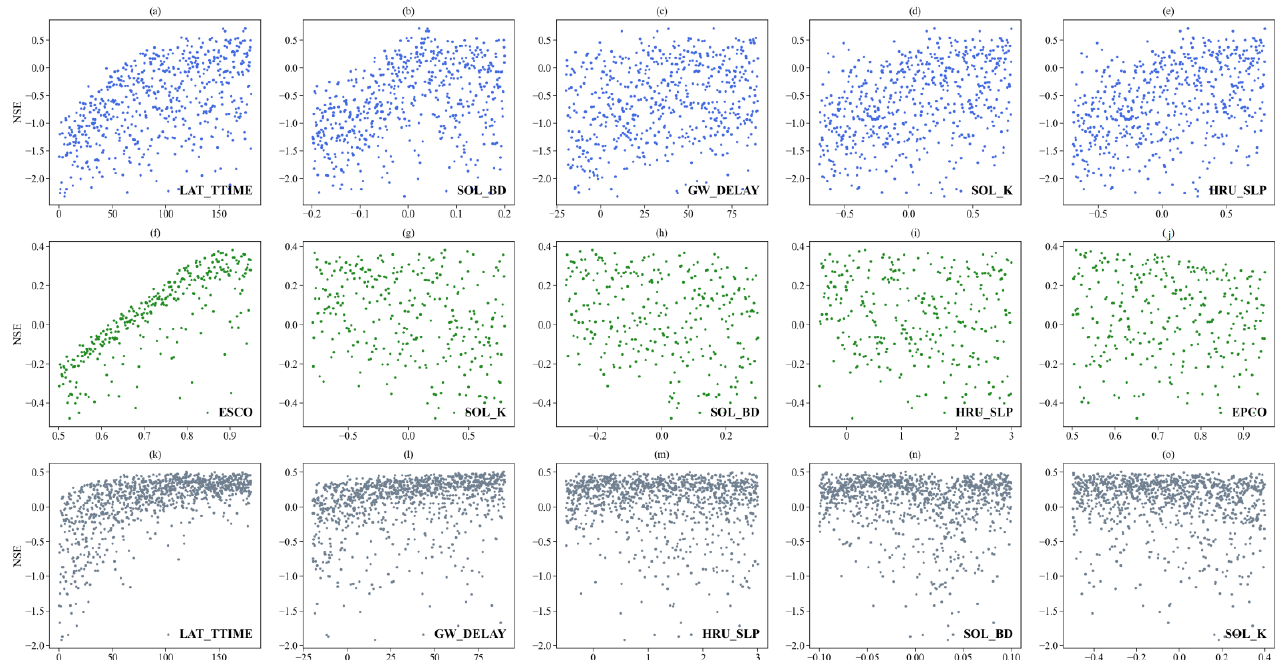
Figure A1. Calibrated values ( x -axis) versus objective function NSE value range ( y -axis); blue dots symbolize streamflow calibration, green dots symbolize AET calibration, and grey dots symbolize multi-variable calibration. The parameters ( a – e ) are the most sensitive parameters for streamflow calibration, the parameters ( f – j ) are the most sensitive parameters for AET calibration, and the parameters ( k – o ) are the most sensitive parameters for multi-variable